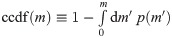
The first order solution of the coagulation Eq (1) with exponential kernel (5) and initial distribution Eq (7) is given by Eq (18) with θ(t) determined via Eq (21).Here, we show the corresponding survival function (or complementary cumulative distribution function) ccdf(m)≡1-∫0mdm′p(m′) for μ = 0.5 and α = 0.01. The dependence on α is extremely weak, which is why we do not show different choices. The times t are chosen in correspondence to the dataset considered by Cefis et al. [33]. All distributions are normalized to one at all times t.